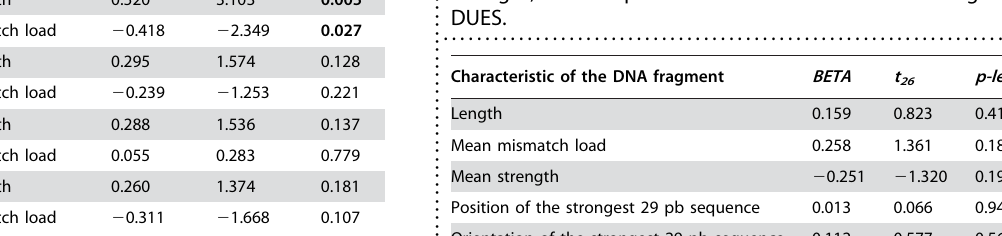
Table 4. Lack of dependence of uptake efficiency on the length of the DNA fragment, its average mismatch load, strength, and the position and orientation of its